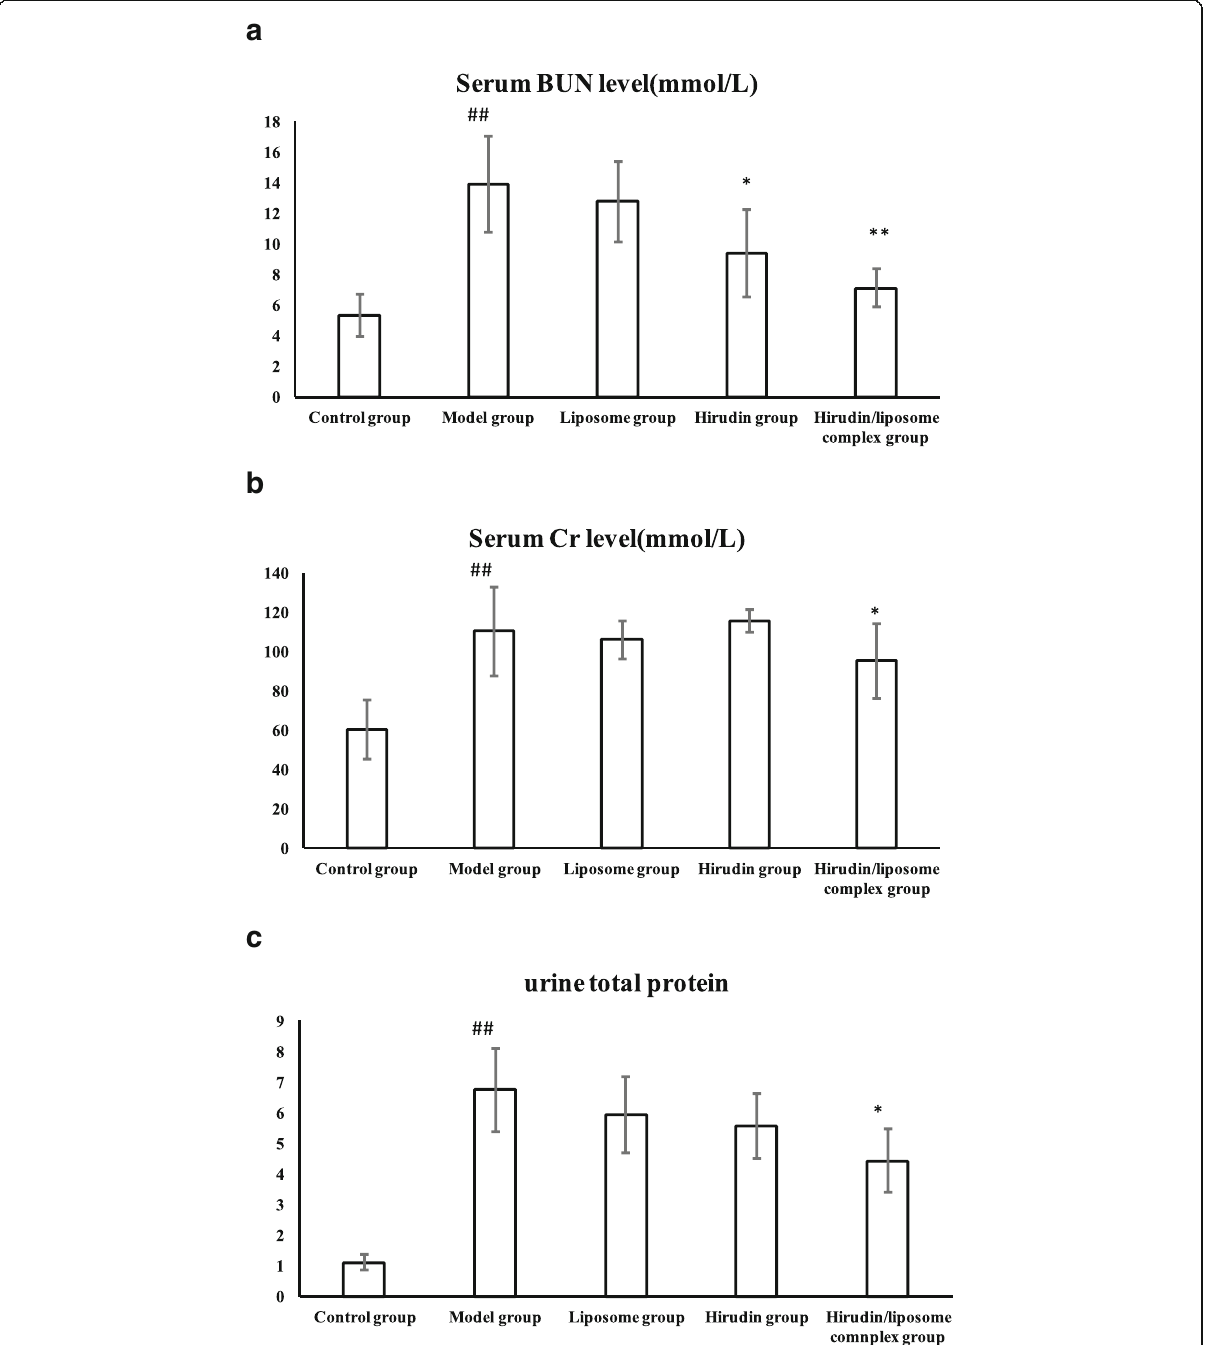
Fig. 6 The hirudin/liposome complex treatment reduced the levels of serum BUN ( a ), Cr ( b ), and 24-h urine protein ( c ) in DN rat models. Control group (n = 10), Model group ( n = 7), Liposome group ( n = 7), Hirudin group ( n = 8), Hirudin/liposome complex group ( n = 7). ##: P <0.01 compared with the Control group; *: P <0.05 compared with the Model group;**: P <0.01 compared with the Model